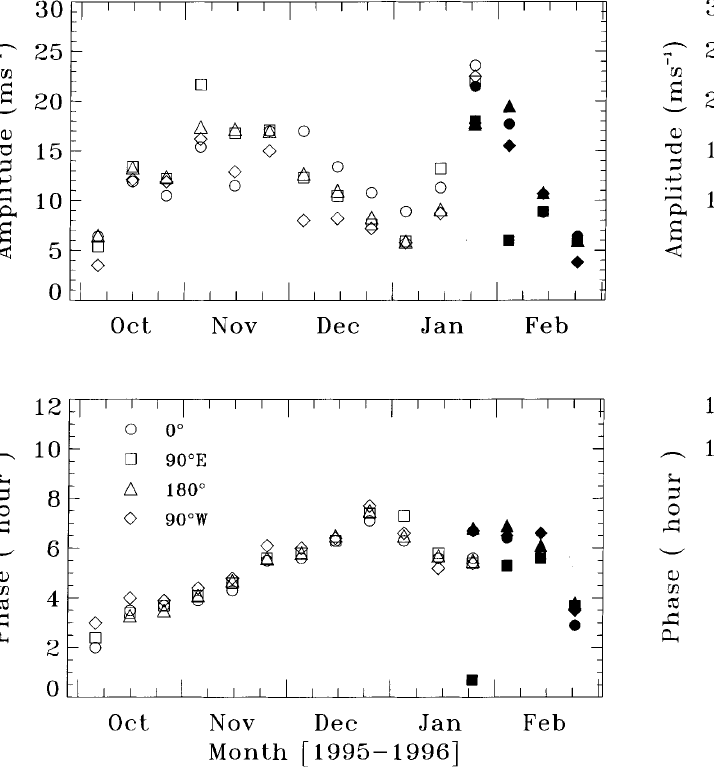
Fig. 2. Ten-day vector-average amplitudes and phases for the 12-h oscillation from 1 October 1995 through 26 January 1996 ( open symbols ) and 19 January 1995 to 18 February 1995 ( filled symbols ). The phases for all azimuth measurements were reduced to a single azimuth under the assumption of a zonal wavenumber s (cid:136) 1 oscillation which is westward propagating